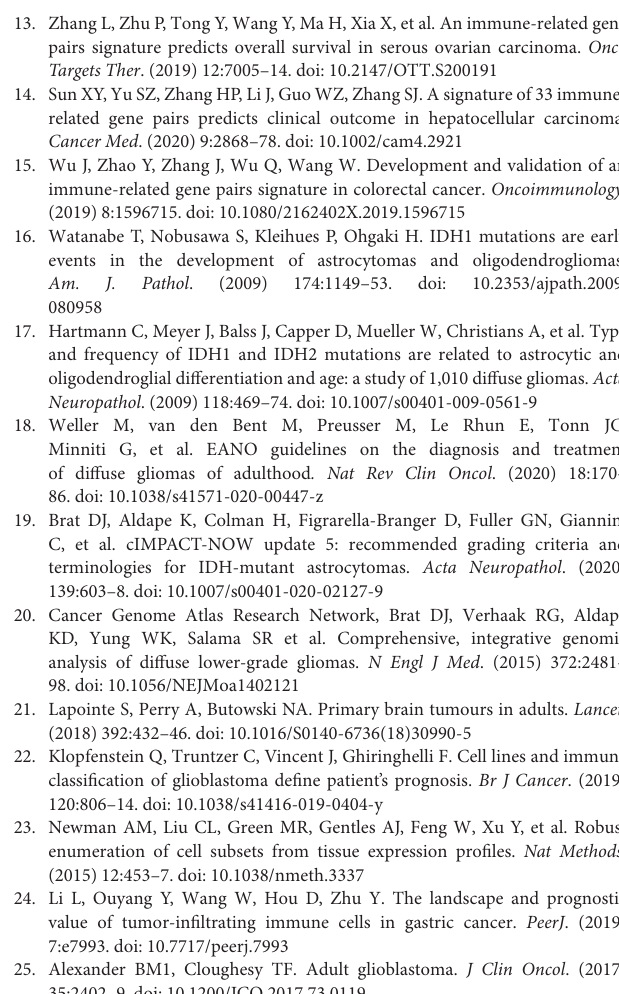
Supplementary Figure 1 | Distribution of risk score and survival status. (A) Training cohort, (B) Validation cohort 1, (C) Validation cohort 2. Supplementary Figure 2 | The area under the curves (AUCs) of clinical indexes for predicting 1-, 3-, and 5-year OS. (A–C) in the Training cohort. (D–F) in Validation cohort 1. (G–I) in Validation cohort 2. AUC, the area under the receiver operating characteristic curve; OS, overall survival. Supplementary Figure 3 | The different expression of 16 immune-related genes (IRGs) between high- and low-risk groups. ∗ p < 0.05, ∗∗ p < 0.01, ∗∗∗ p < 0.001. Supplementary Figure 4 | Comparison of 22 immune cells between 10 IRGPs scores:1 and 0. (A) The distributions of Macrophages M0 between score:1 and score:0 of IL10RA/OSMR, (B) LEFTY2/MSTN, (C) SLC11A1|TRIM22. (D) The distributions of Macrophages M1 between score:1 and score:0 of FCGR2B|PRKCB, (E) LEFTY2|MSTN, (F) SLC11A1|TRIM22. (G) The distributions of resting memory CD4 T cells between score:1 and score:0 of BMP2|NOV, (H) FCGR2B|PRKCB, (I) LEFTY2|MSTN, (J) SLC11A1|TRIM22. (K) The distributions of Tregs cells between score:1 and score:0 of BMP2|NOV (L) FCGR2B|PRKCB, (M) LEFTY2|MSTN, (N) SLC11A1|TRIM22, (O) FCGR2B|PRKCB. Supplementary Table 1 | P-values of Wilcoxon test for the distribution of 22 immune cells between 10 IRGPs score:1 and